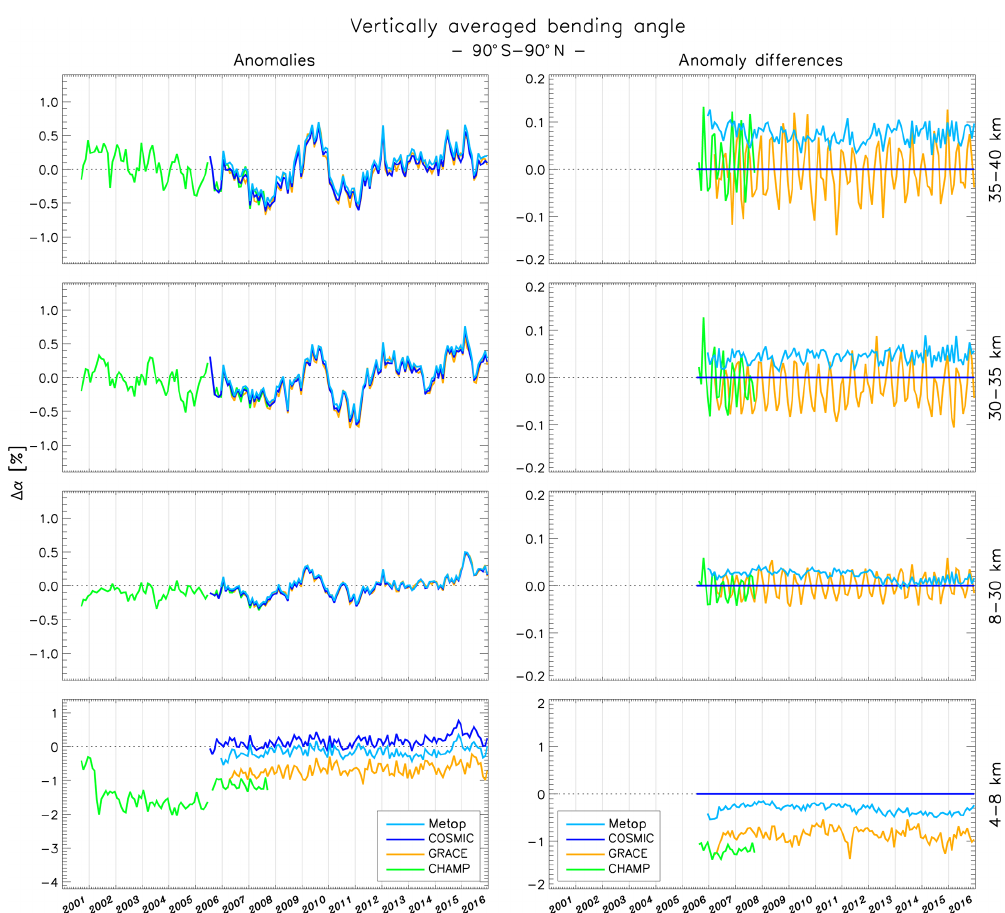
Figure 9. Monthly mean bending angle anomalies for the four RO missions (left panels) and differences of CHAMP, GRACE, and Metop with respect to COSMIC (right panels). From bottom to top, the panels show the 4–8, 8–30, 30–35, and 35–40km height layers. Note that for the lowest plots, the vertical axes have been compressed to accommodate the larger differences between the